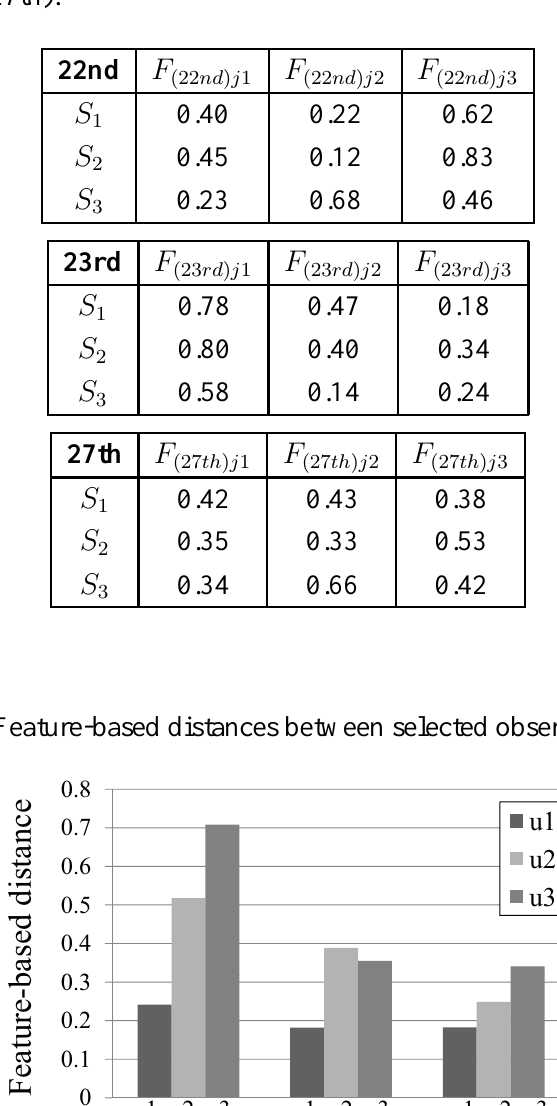
, 𝑆 , and 𝑆 ) in three selected days 1 2 3